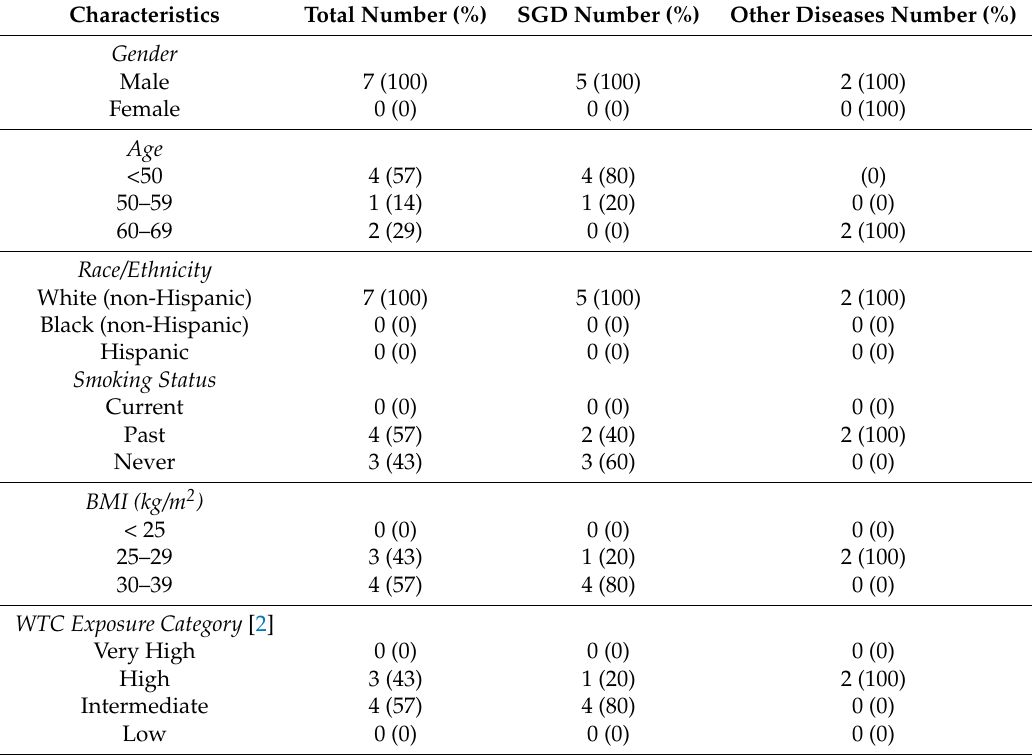
Table 1. Demographic characteristics of patients undergoing